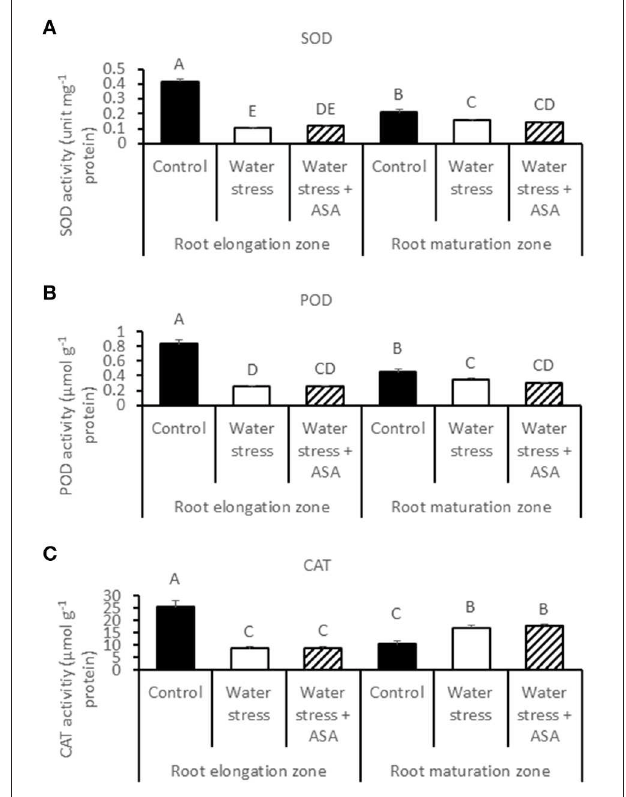
FIGURE 6 | Activity of superoxide dismutase (SOD) (A), peroxidase (POD) (B), and catalase (CAT) (C) in tall fescue roots exposed to non-stress control, water stress, and water stress with ASA treatment. The data represent mean ± SE ( n = 4 replicated pots of plants and each pot with multiple plants). Columns marked with the same letter are not significantly different at p < 0.05